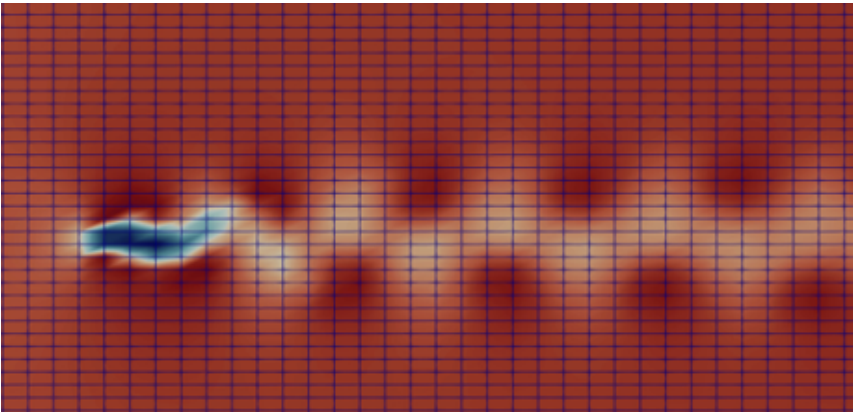
Figure 4. The finite element projection of the instantaneous velocity, Figure 2, on mesh n°2 in Table 1.